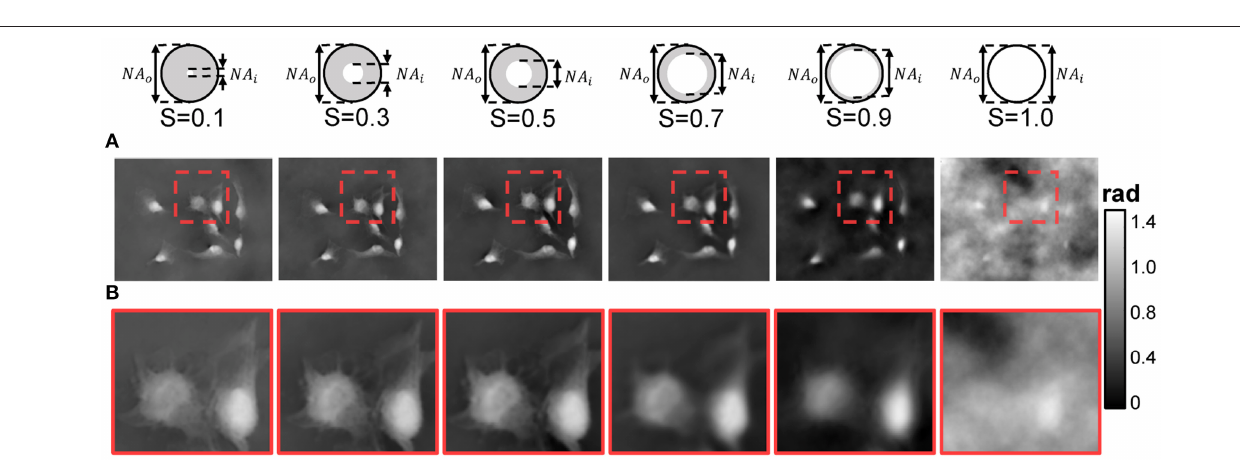
FIGURE 6 | Recovered phases of HeLa cells under different coherence parameters S ( S = NA i / NA o ). (A) Recovered phases. (B) Enlarged version of red box area in (A)